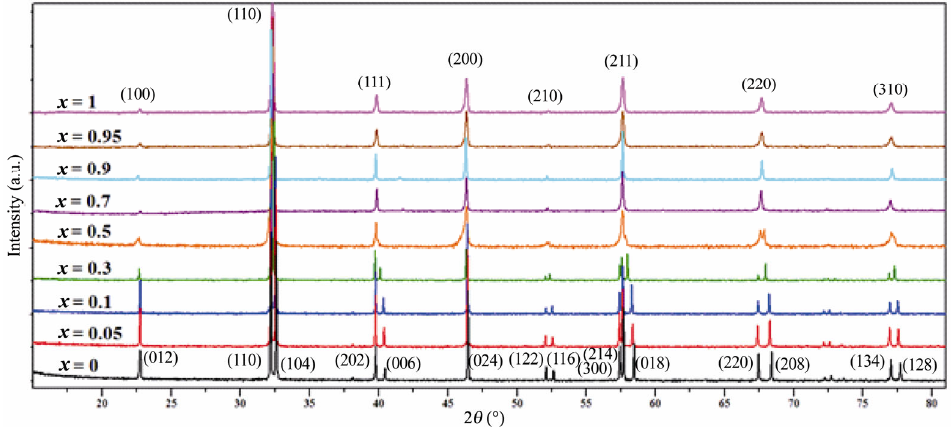
Fig. 2 XRD patterns of the La 1– x Sr x CoO 3 solid solution at room temperature with 0 ≤ x ≤